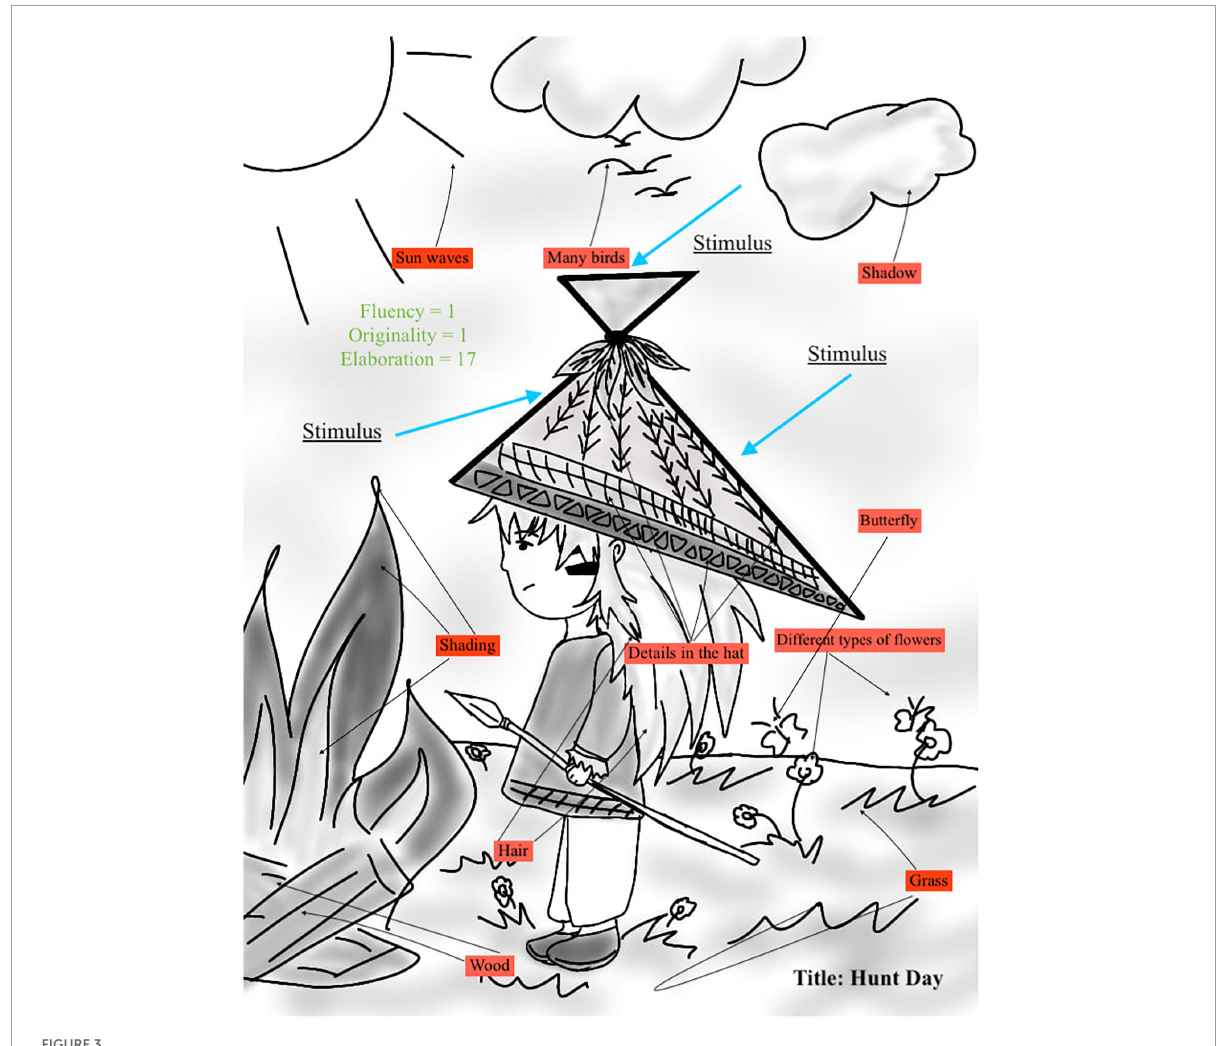
FIGURE3 Example of scoring